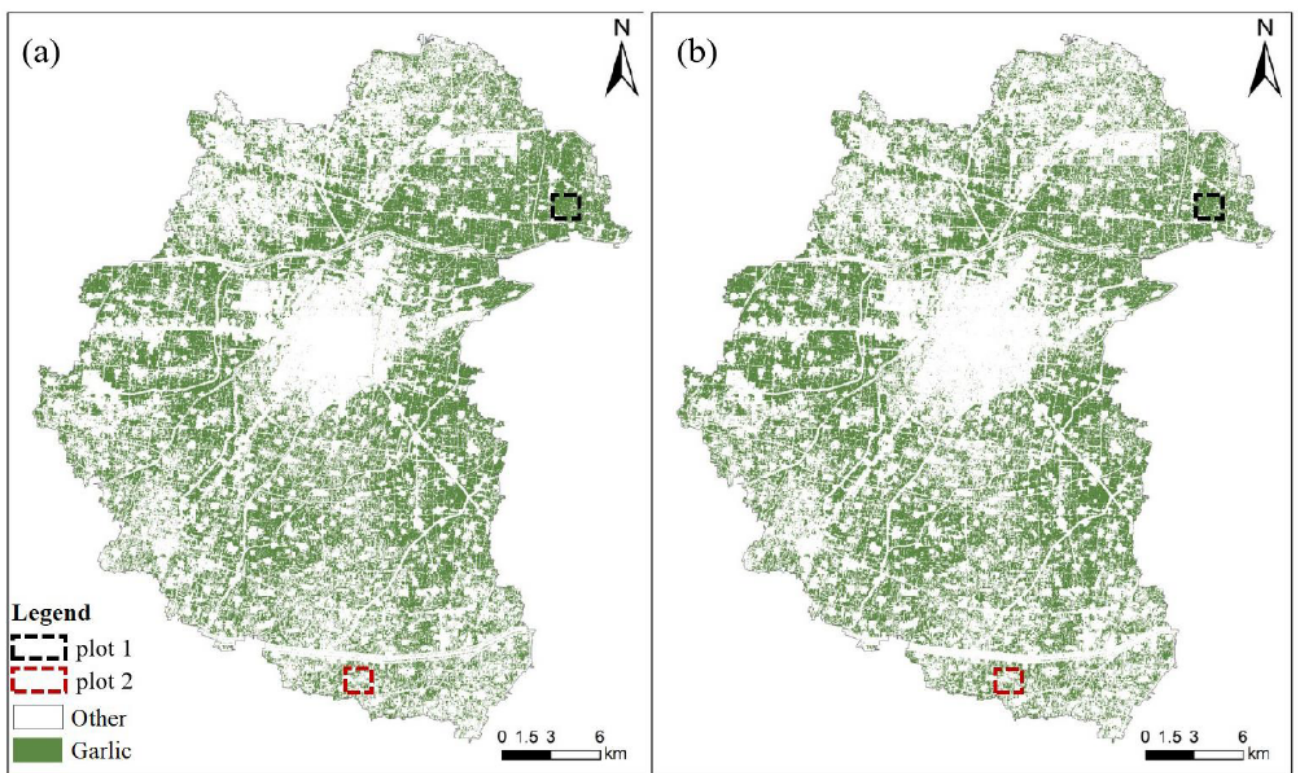
Figure 11. Garlic extraction results of ( a ) optimal multi-temporal and ( b ) mono-temporal schemes.